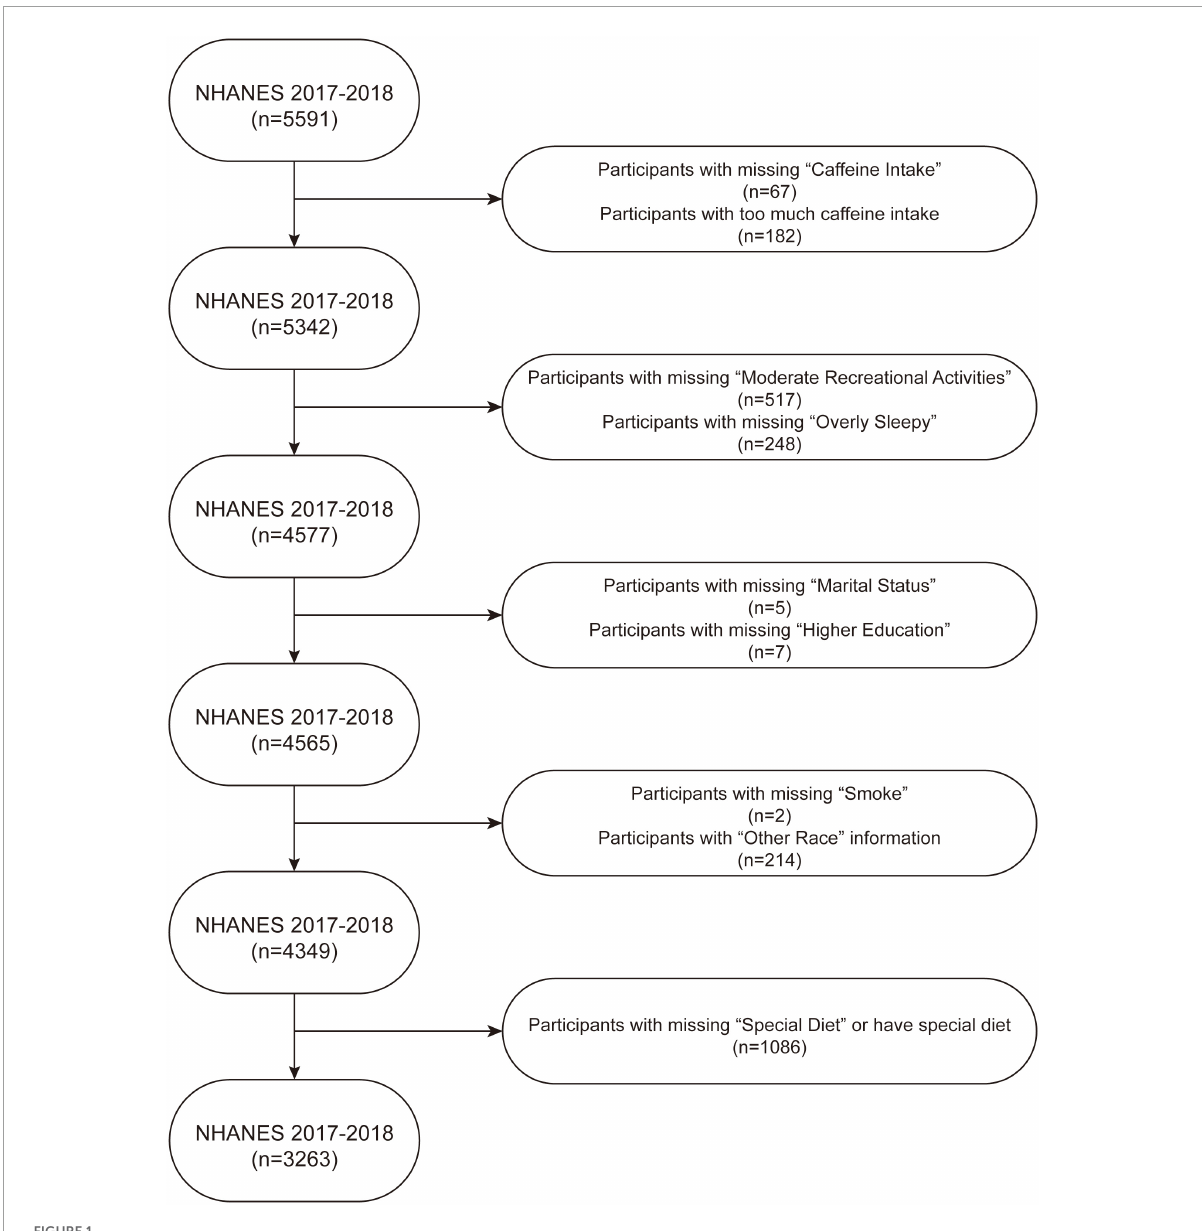
FIGURE1 Flow chart of sample selection from the NHANES 2017–2018.